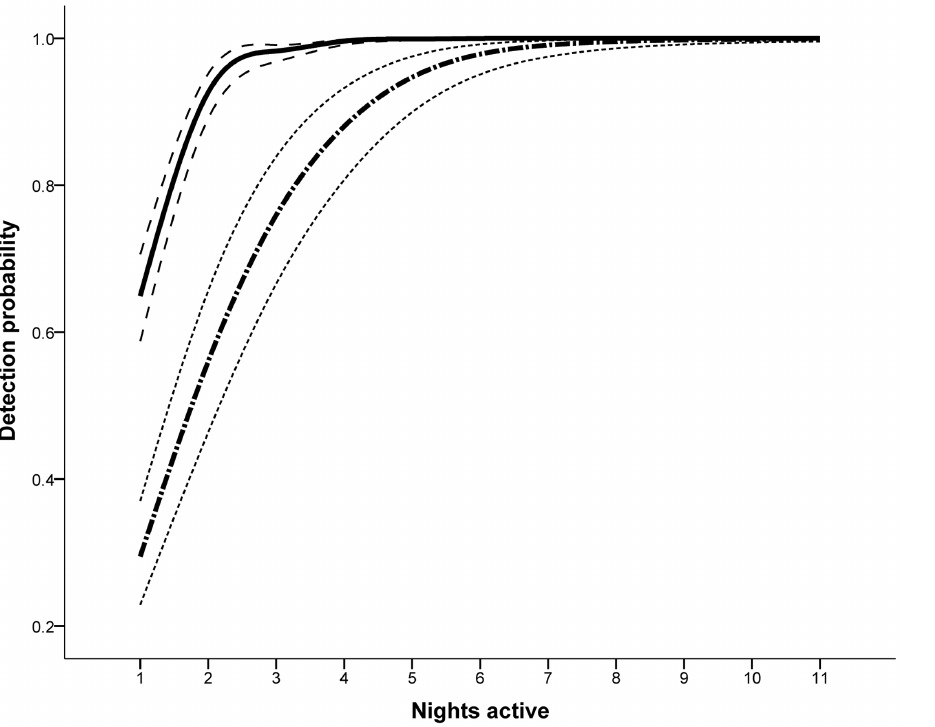
Figure 2. The detection probabilities obtained using this camera trapping approach. Nightly detection probability, including upper and lower 95% confidence intervals for black rats (solid line) and house mice (dot-dashed line).